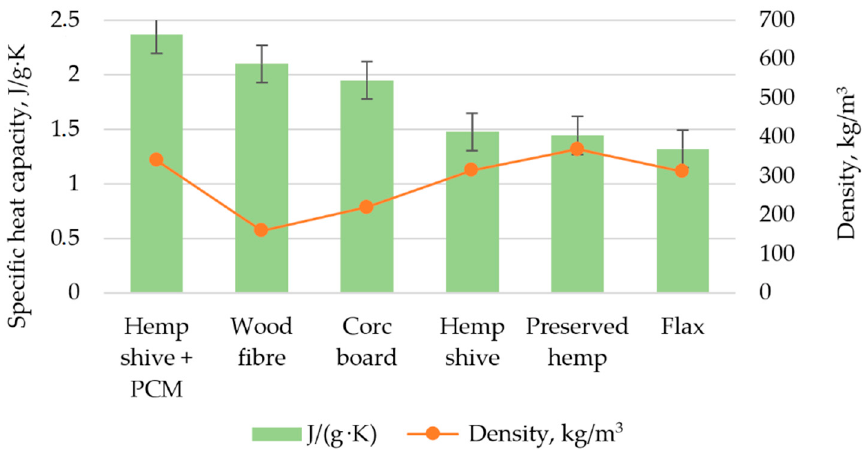
Figure 13. Specific heat capacity of experimental and reference boards [40,41].